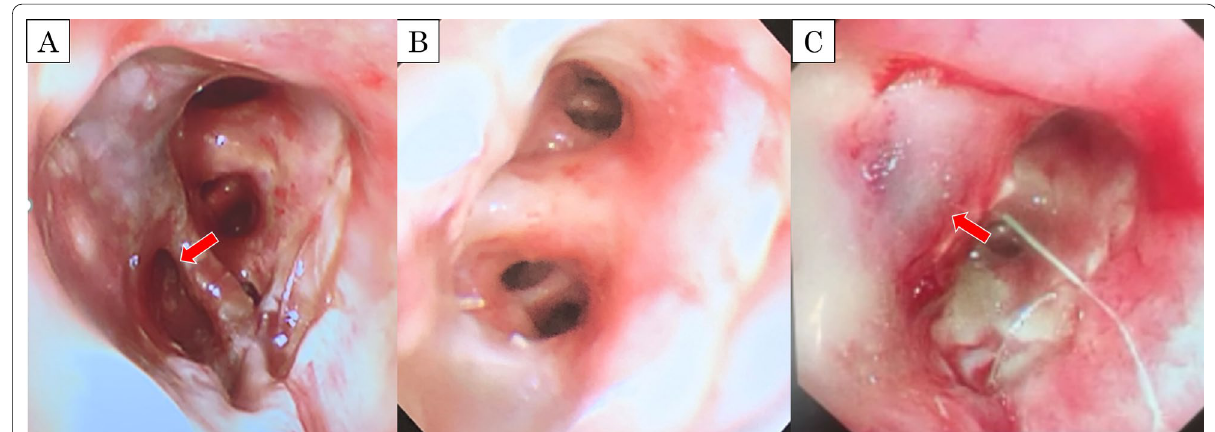
Fig. 4 Serial bronchoscopic findings. A The half circle of the bronchial anastomosis site indicates ischemia on postoperative day (POD) 17 (red arrow). B The anastomosis site undergoing epithelialization on POD 34. C The pulmonary artery is stuck in the bronchial anastomosis site on POD 114, suggesting impending rupture (red